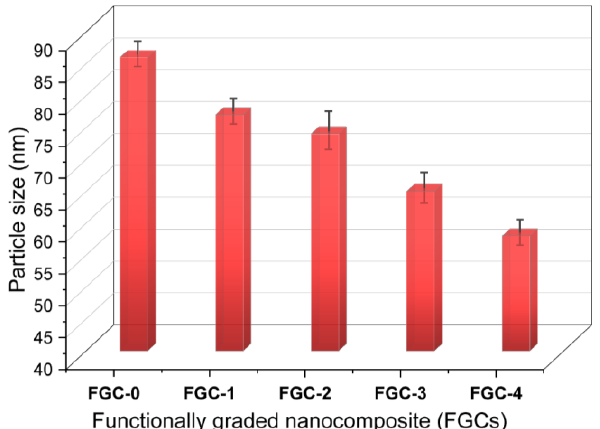
Figure 4. TEM images of (a) FGC-0, (b) FGC-1, (c) FGC-2, (d) FGC-3, and (e) FGC-4 powders after 20 h of milling.